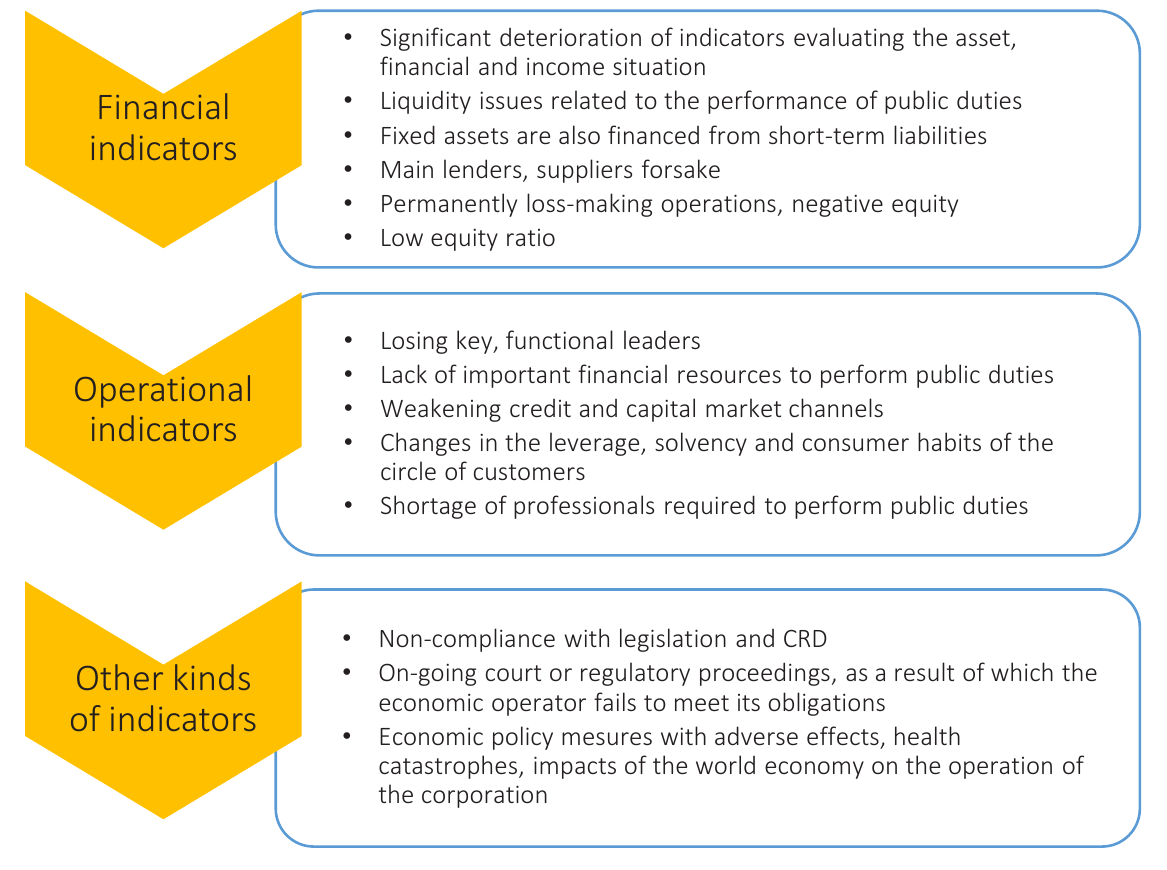
Figure 1. Indicators of operational